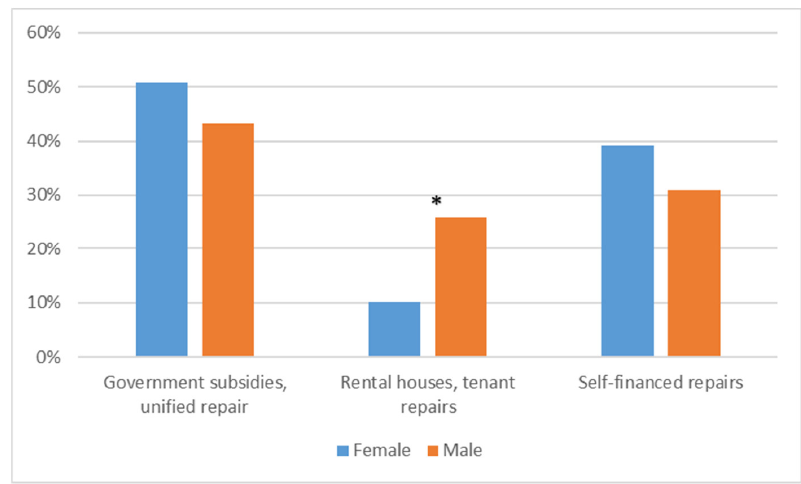
Figure 4. Variations in management mode as perceived and preferred by respondents by gender. Asterisks indicate significance level: * means 0.01 ≤ p ≤ 0.1.